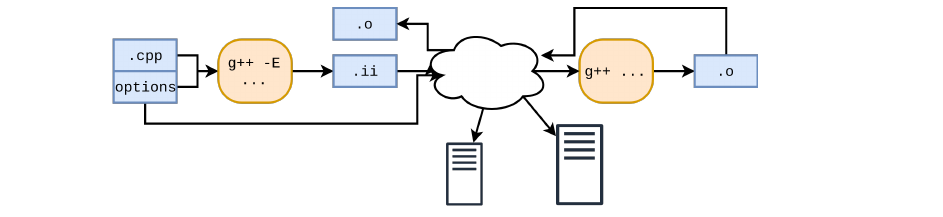
Figure 3. Schematic view of the standard mode of operation of distcc. The C preprocessor runs locally and only the compilation of its output is